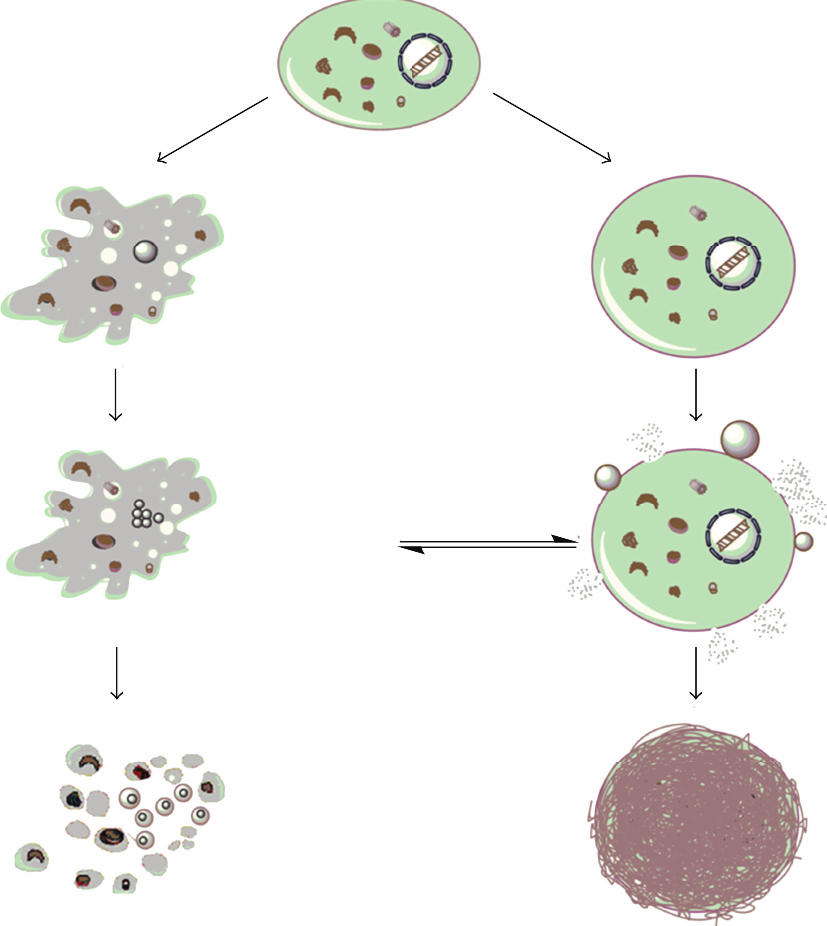
Figure 4: Mode of cell death induced by cisplatin: apoptosis (left) and necrosis